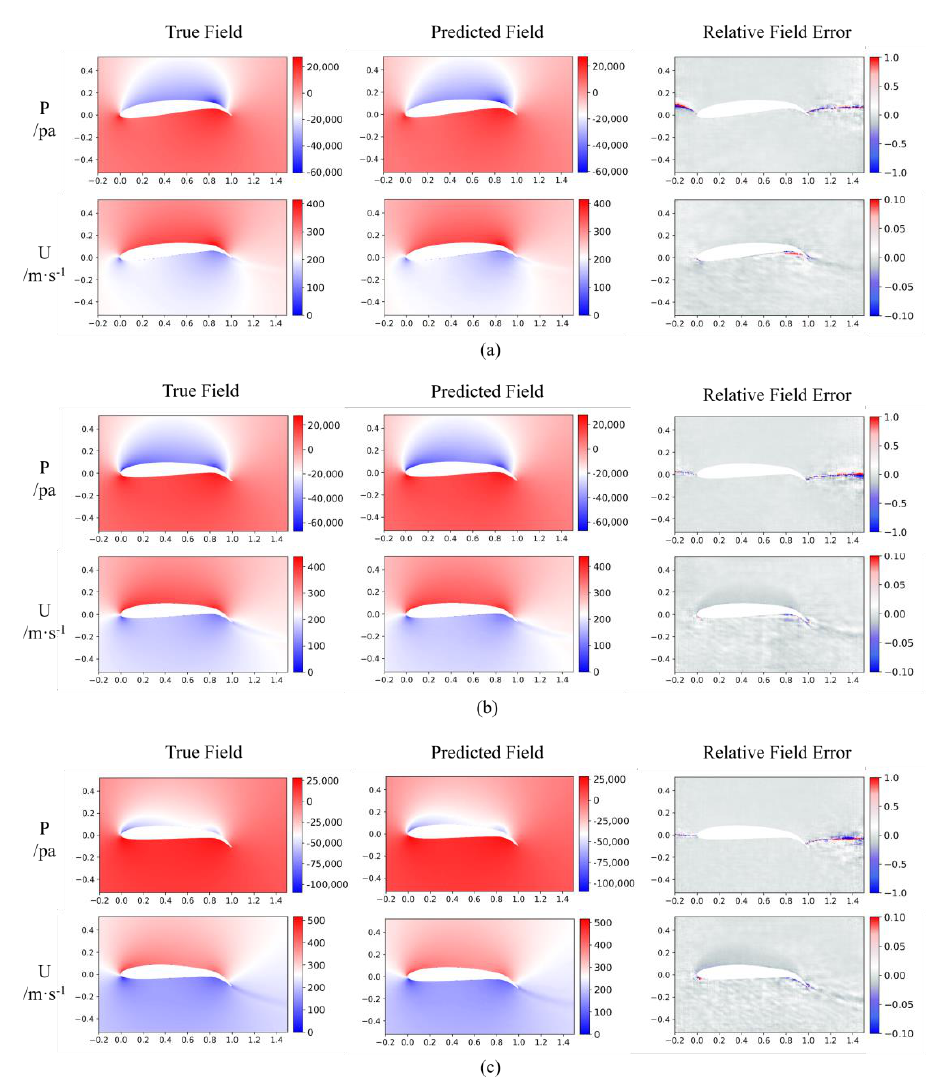
Figure 12. The true (CFD) and predicted physical fields for NACA9812 airfoil under Re = 7 × 10 6 across three AOAs: ( a ) 0°; ( b ) 4°; ( c ) 6°.